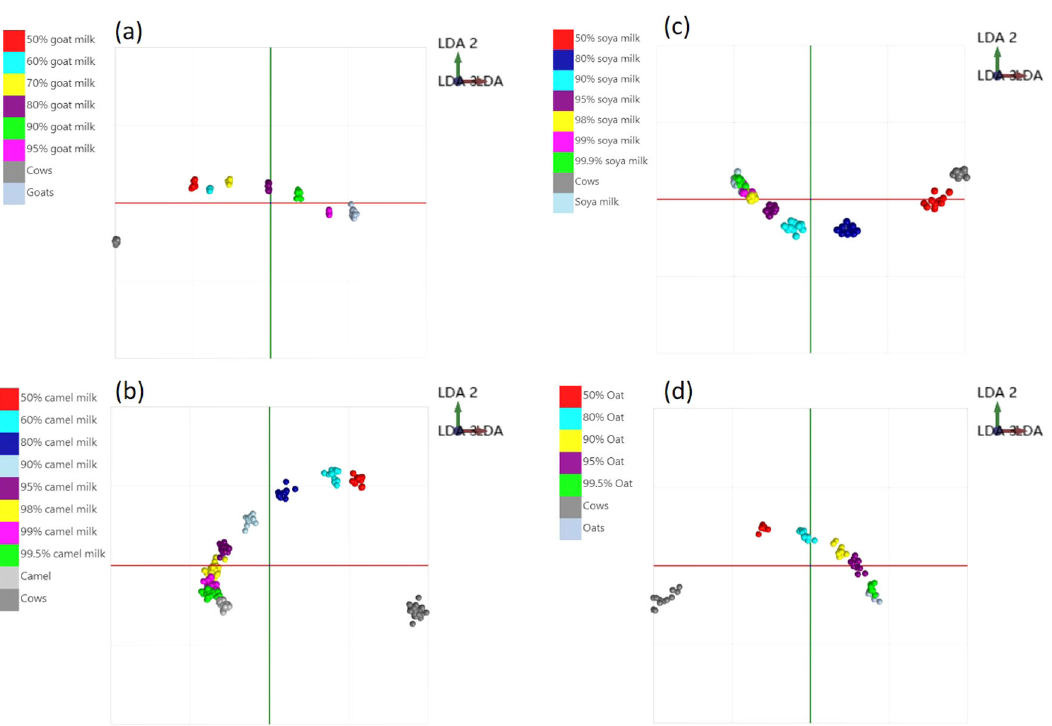
Fig. 8 LDA analysis of different milk species adulterated with different milk species. Goat milk ( a ), camel milk ( b ), soya milk ( c ), and oat milk ( d ) in different